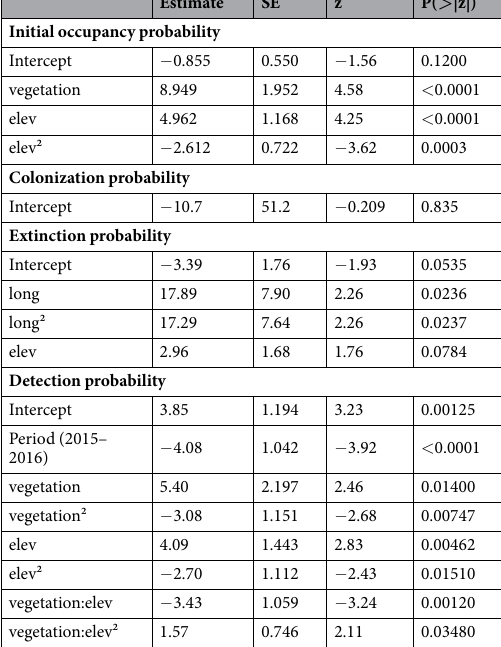
Table 1. Summary results of the best dynamic occupancy model for the range dynamics of the European goldfinch ( Carduelis carduelis ) in western Maghreb from 1990–1991 to 2015–2016. Covariates include vegetation cover (vegetation), elevation (elev), longitude (long), and period (primary sampling period). Colons indicates